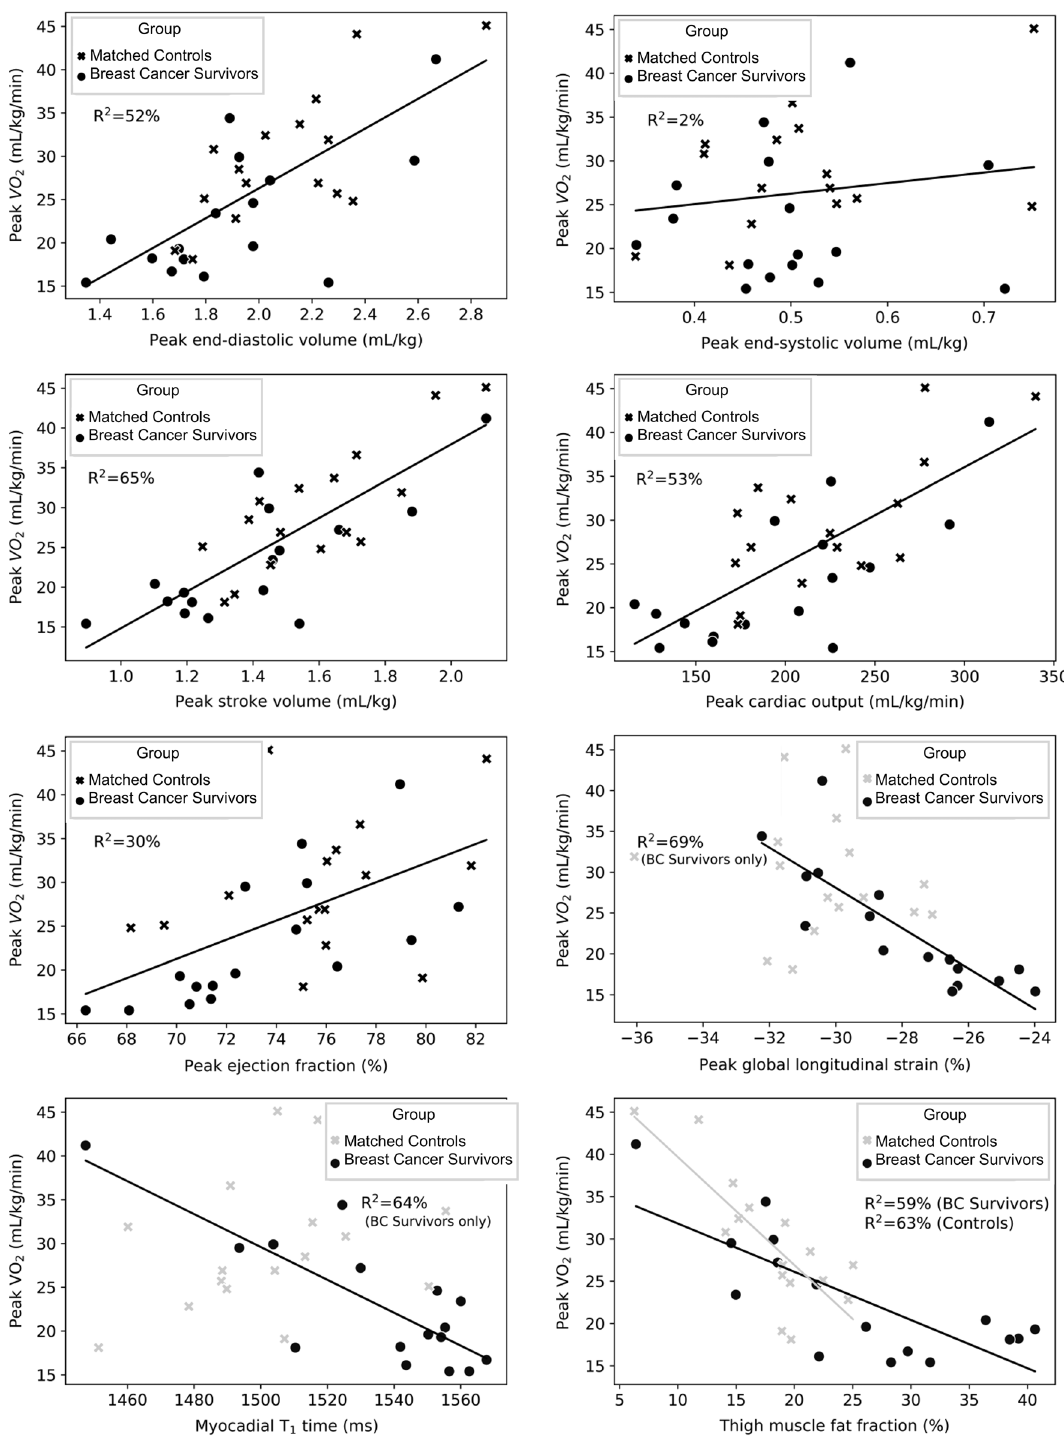
Figure 4. Predictors of peak volume of oxygen consumption (VO 2 ) among anthracycline-treated breast cancer survivors and age- and body mass index-matched non-cancer controls. Trend line colors match included data. Both VO 2 and volumes are normalized to body weight (kg) to standardize